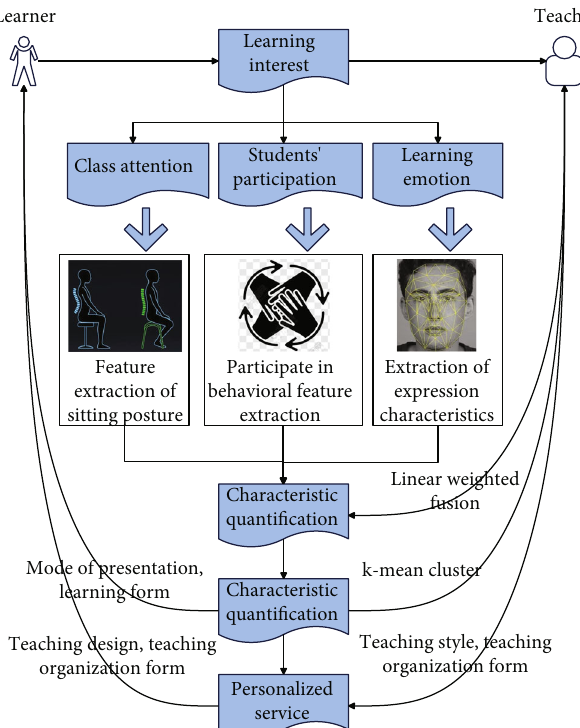
Figure 8: The recognition model of students ’ interest in English classroom